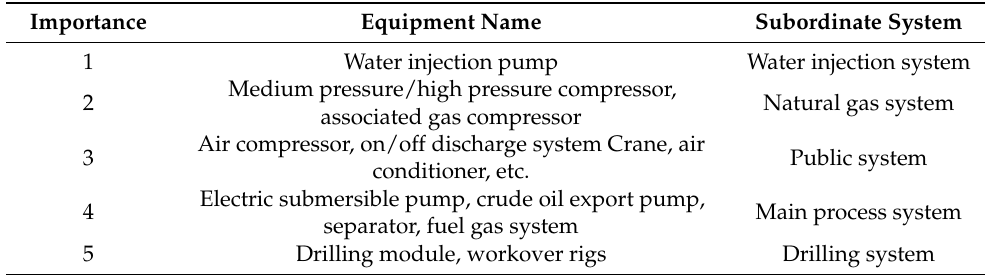
Table 2. The equipment and its subordinate system.